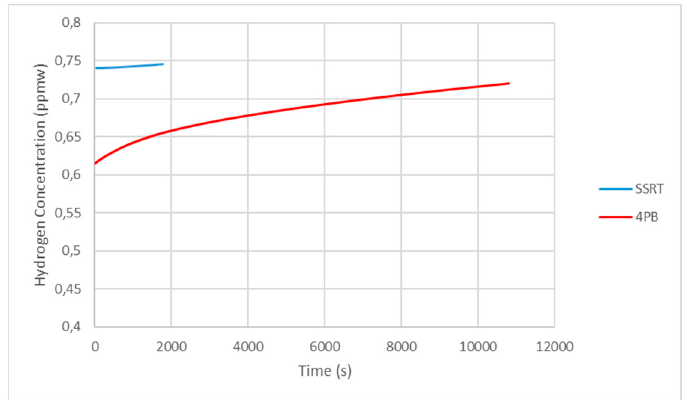
Figure 12. Hydrogen accumulation at the crack tip during the test. Note: simulation refers to USIBOR 1500 ® .